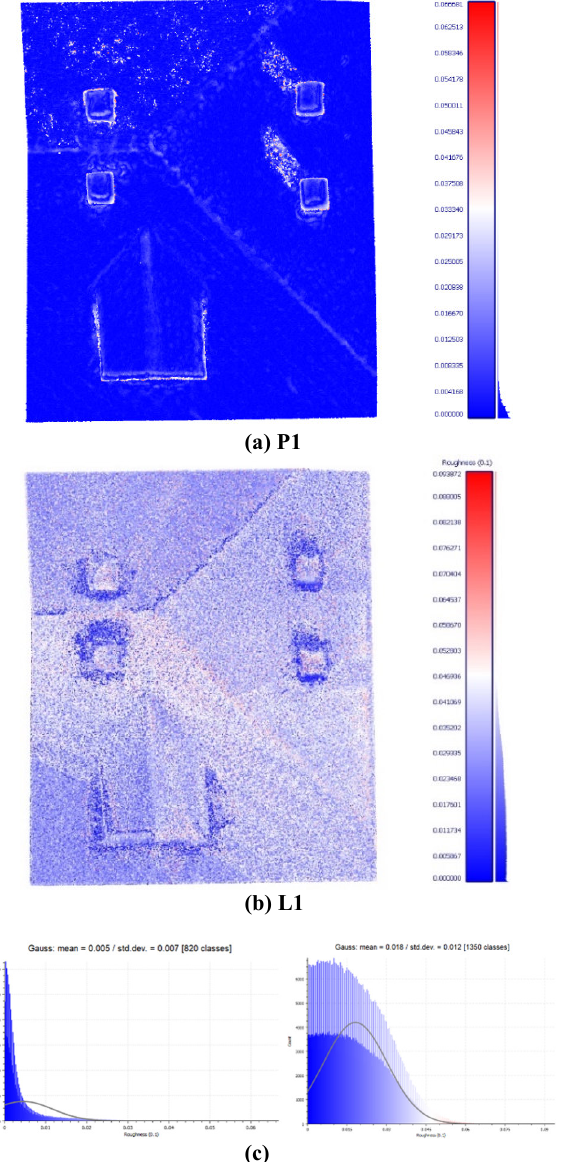
Figure 9. Roughness analyses of a roof area, computed with a radius of 0,1 m. P1 (a) is used as ground reference and L1 (b) as compared dataset. On the bottom (c), the gaussian distribution for P1 on the left and L1 on the right.